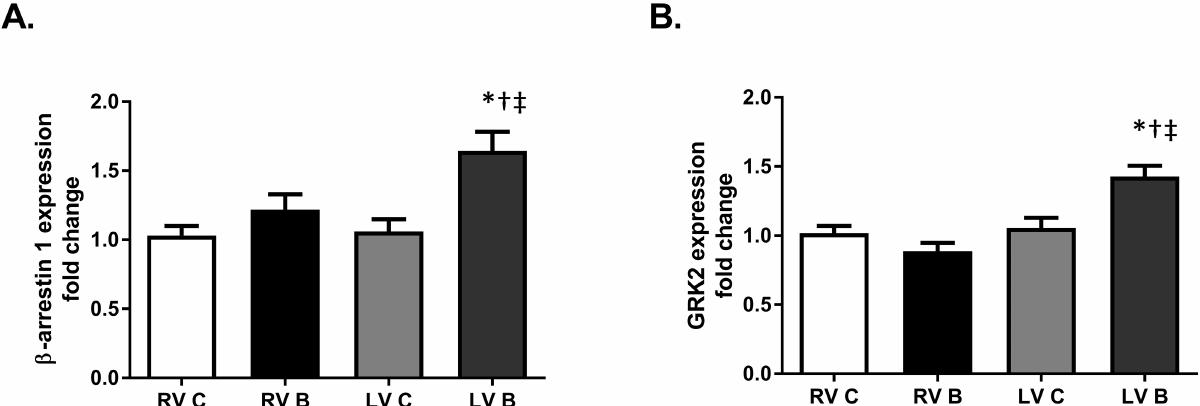
Fig 4. Gene expression of β -AR desensitization proteins post-burn. (A) β -arrestin1 mRNA expressionfrom right and left ventriclesand (B) GRK2 mRNA gene from right and left ventriclesat seven days post-burn. Data are expressedas the mean ± SEM. Statistical analysis was performed using a one-wayANOVA. n = 7–9; p = 0.001, < 0.0001respectively;RV C: right ventriclecontrol; RV B: right ventricleburned; LV C: left ventricle control; LV B: left ventricleburned; GRK2, G-protein coupledreceptorkinase 2; * , p < 0.05vs LV C; †, p < 0.05vs RV C; ‡, p < 0.05vs RV B.